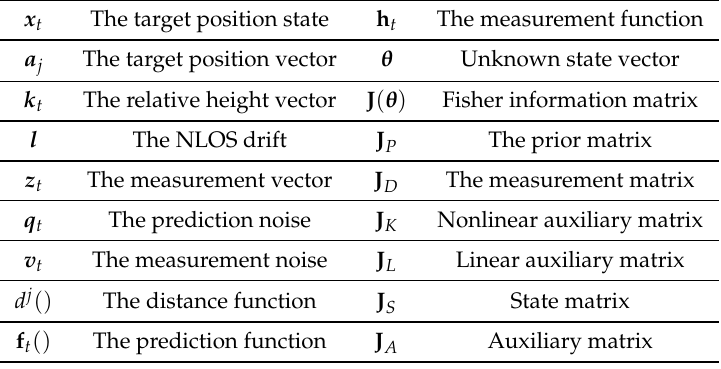
Table 1. Notations and